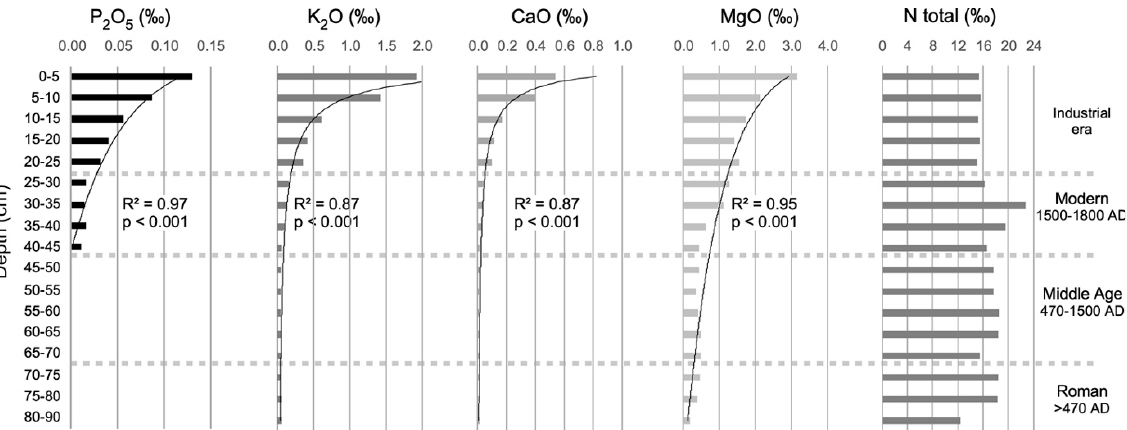
Figure 4. Concentration of phosphorous (P 2 O 5 ), potassium (K 2 O), calcium (CaO), magnesium (MgO), and nitrogen (N-total) as function of peat depth.